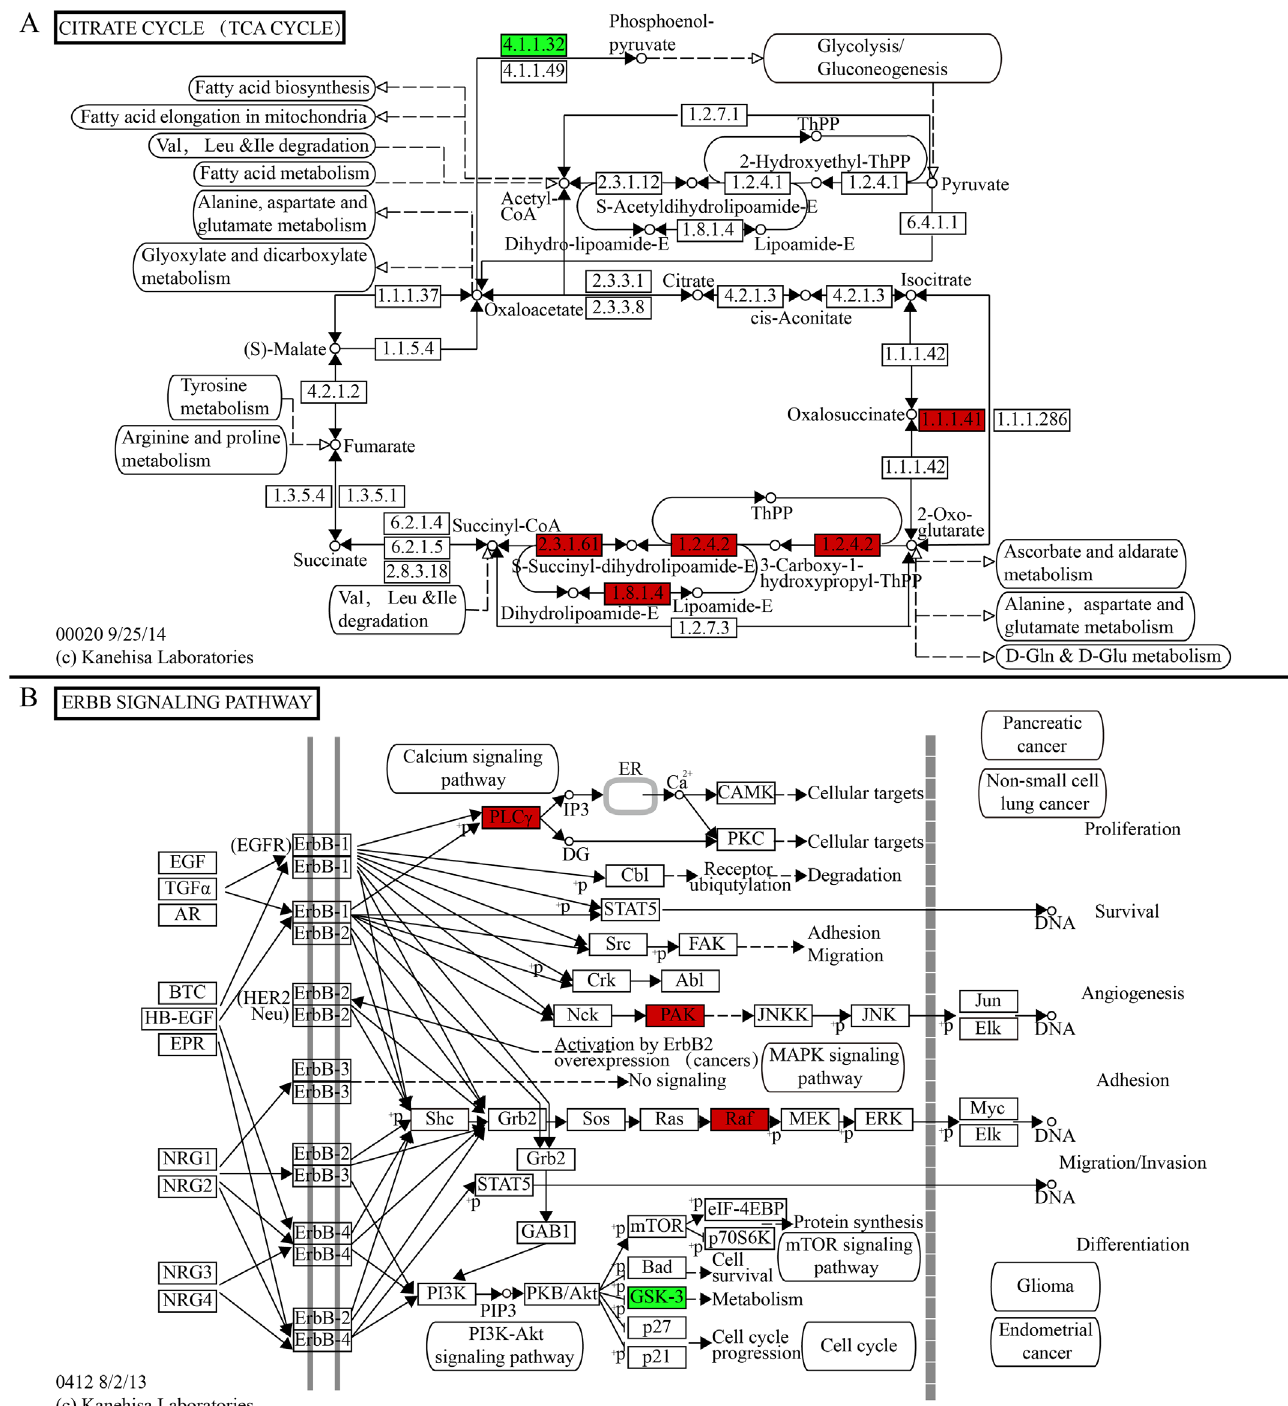
Fig 2. KEGG analysis of differential proteins. (A) Differential proteins involved in the oxidative phosphorylation pathway, 4.1.1.32: phosphoenolpyruvate carboxykinase (GTP), 1.1.1.41: isocitrate dehydrogenase (NAD+), 1.2.4.2: 2-oxoglutarate dehydrogenase E1 component, 2.3.1.61: 2-oxoglutarate dehydrogenase E2 component (dihydrolipoamide succinyltransferase), 1.8.1.4: dihydrolipoamide dehydrogenase. (B) Differential proteins involved in the ERBB pathway. Block in red meant upregulation, downregulation in green.